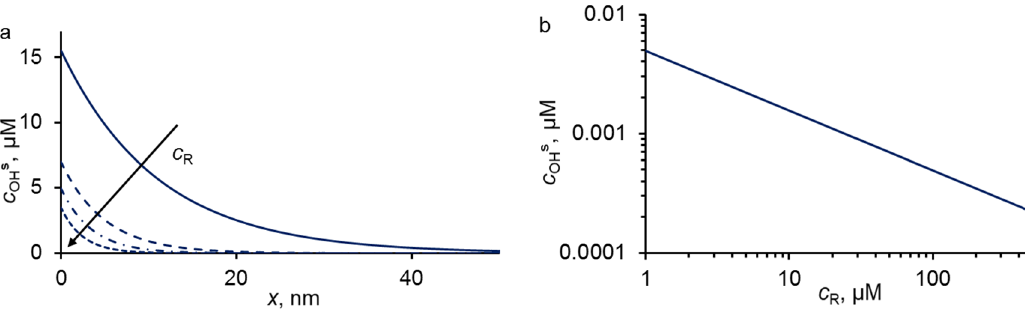
Figure A1. Calculated concentration profiles ( a ) and concentration dependence of hydroxyl radicals on the REM surface ( c HOS ) on the concentration of organic compounds c R ( b ). Parameters used in the calculations: j = 300 A · m − 2 ; D HO = 2.2 × 10 − 9 m 2 · s − 1 , k HO = 5.5 × 10 6 m 3 mol − 1 · s − 1 , k Σ = 6.5 × 10 6 m 3 mol − 1 · s − 1 , α = 28. The arrow represents an increment of the concentration of organic compounds: c R = 0.1, 0.5, 1, 2 mM.